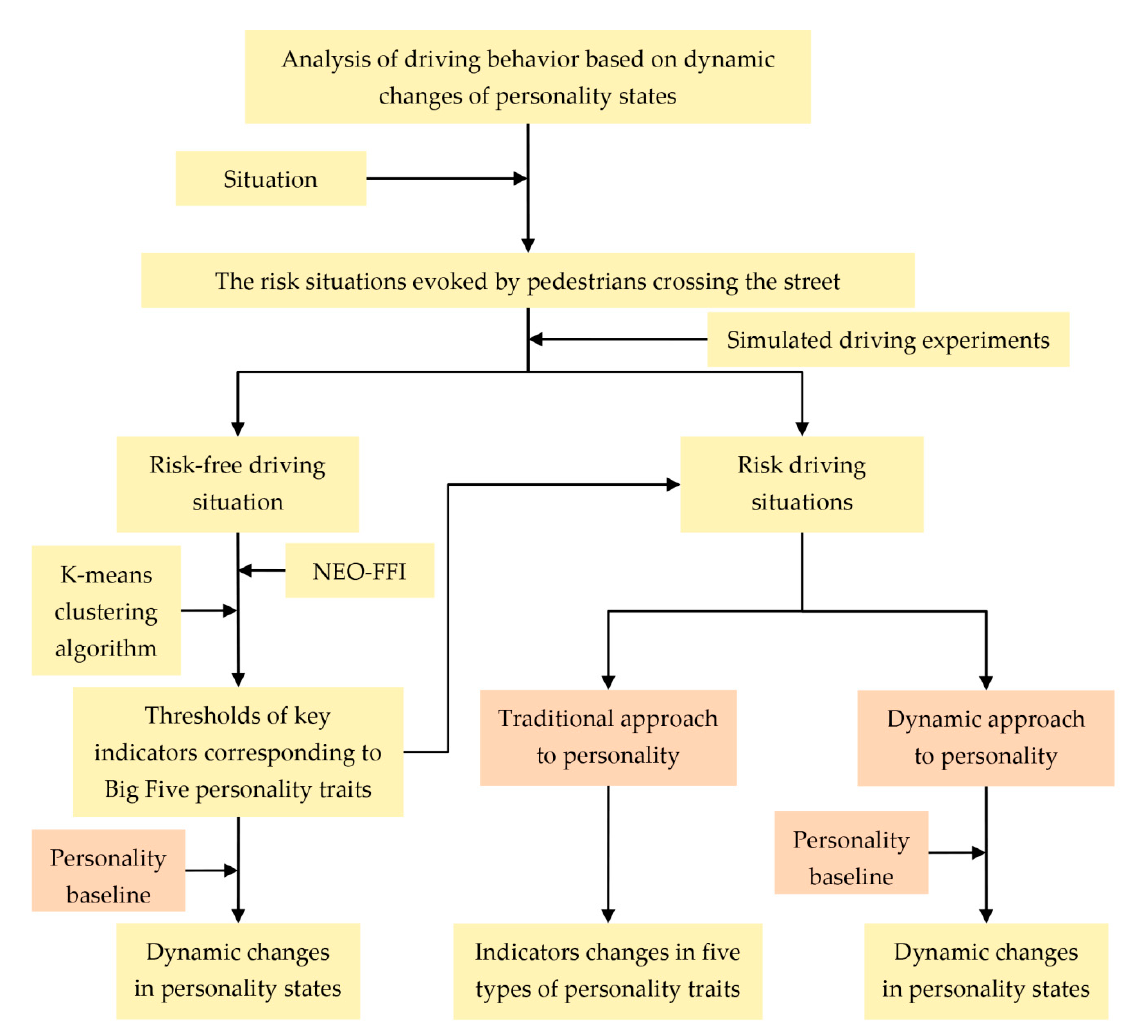
Figure 1. The processes used to analyze the correlation between personality states and driving behavior. Note: NEO-FFI: Neuroticism Extraversion Openness Five-Factor Inventory.